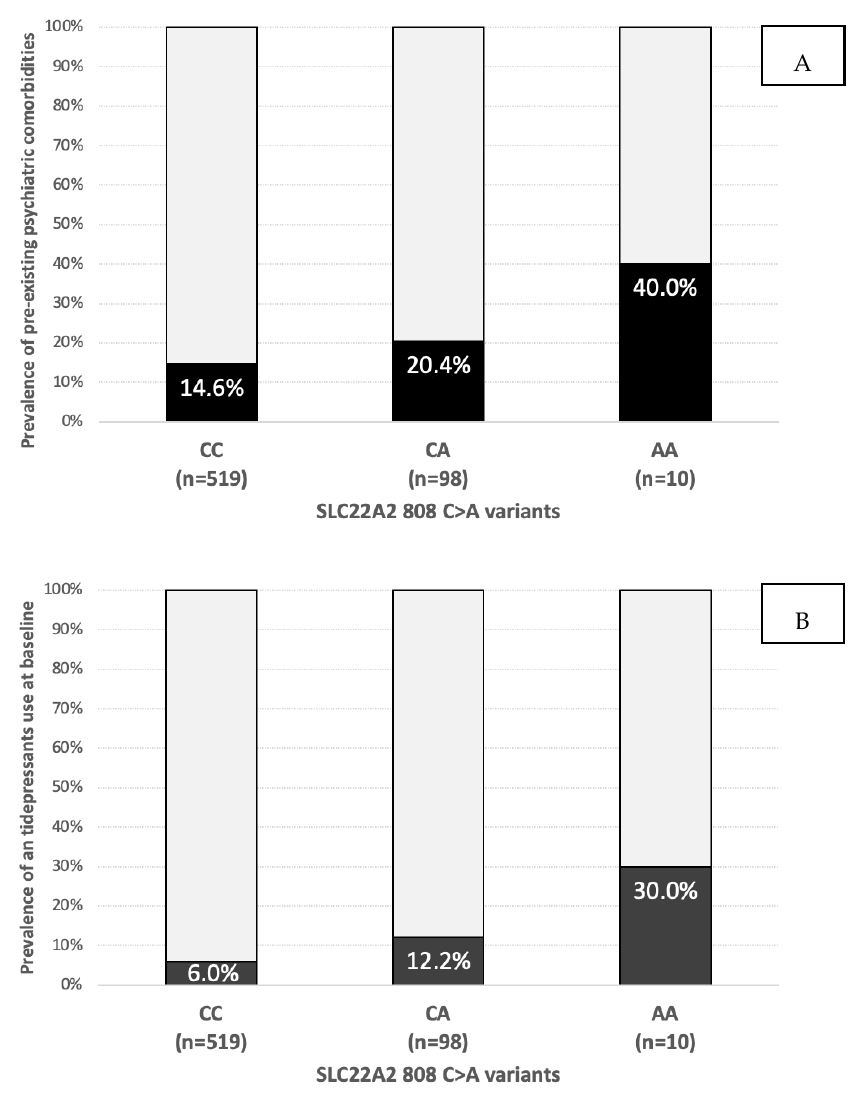
Figure 1. Prevalence of pre-existing psychiatric comorbidities ( A ) and antidepressant use ( B ) according to SLC22A2 variant.